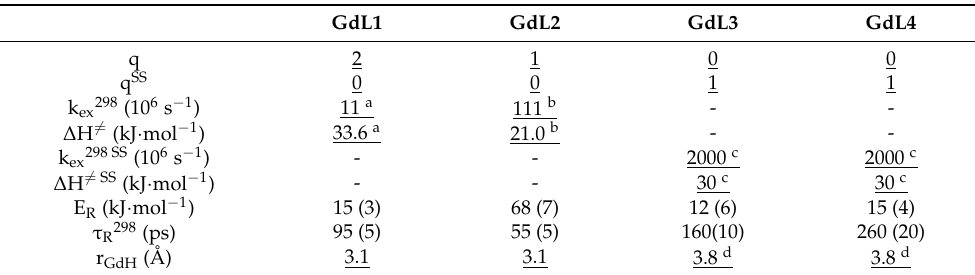
Table 2. Main parameters obtained from the fitting of the NMRD profiles. Underlined parameters have been fixed. SS stands for